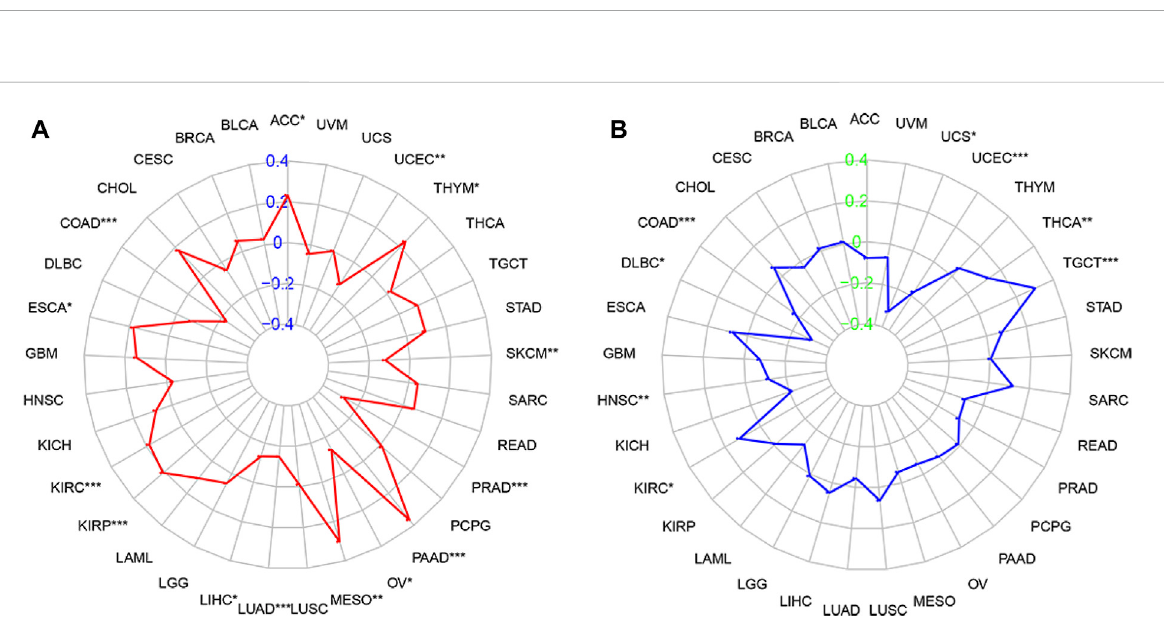
FIGURE 8 Correlation of forkhead box Q1 (FOXQ1) expression with tumor mutational burden (TMB) and microsatellite instability (MSI) in pan-cancer. (A) association of TMB with FOXQ1 expression in different cancers. The red curve represents the correlation coef fi cient, and the blue value represents the range. (B) relationship of MSI with FOXQ1 expression in different cancers. The blue curve represents the correlation coef fi cient, and the green value represents the range. * p < 0.05, ** p < 0.01, and*** p <